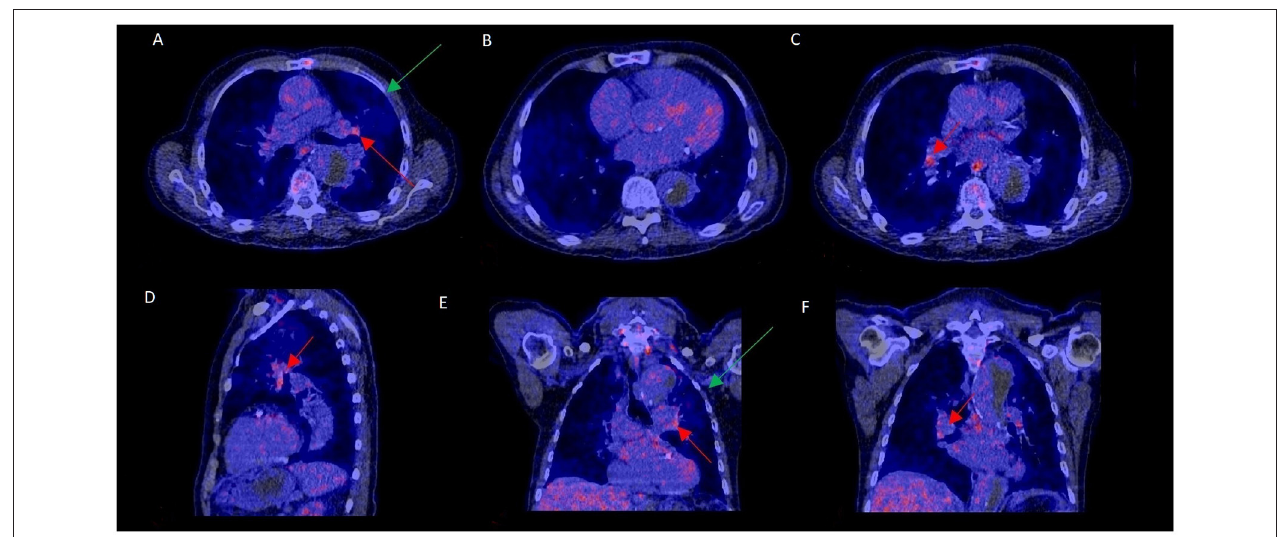
FIGURE 3 | 18 F-FDG-PET/CT scan with increased mediastinal lymph node FDG activity without PVE. This 70–75 year old patient presented with a type B aortic dissection and an unexplained fever. PET/CT was performed to rule out PVE. FDG uptake was increased in mediastinal hilar lymph nodes ( A,C–F : red arrows) but not at the aortic prosthetic valve (B) . PVE was ruled out during surgery, performed to treat the dissection. Slightly elevated FDG uptake and a consolidation in the left upper lobe ( A,E : green arrows) were consistent with a mild pneumonia in remission, which may have accounted for the increased lymph node